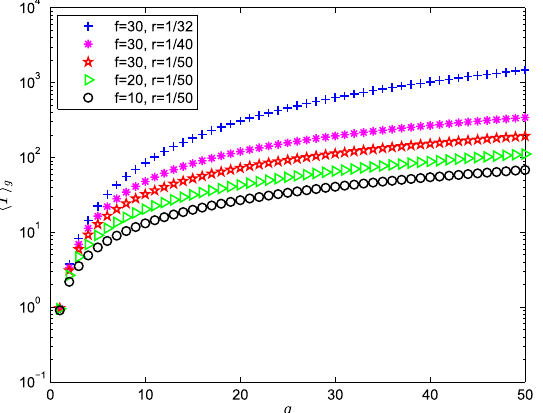
Figure 7. Average receiving time 〈 T 〉 g versus g is on a semilogarithmic scale for the range of < <